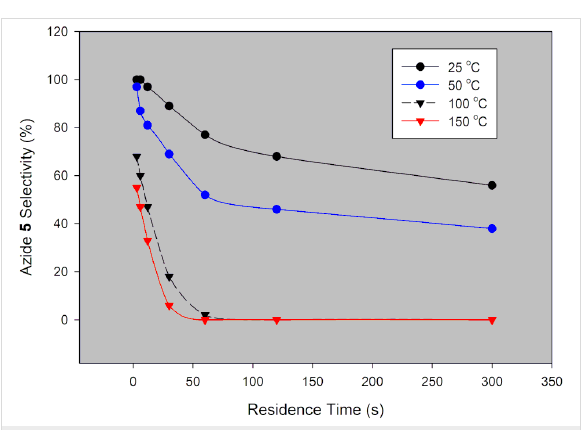
Figure 9: Desired azide 5 selectivity in a continuous-flow system using